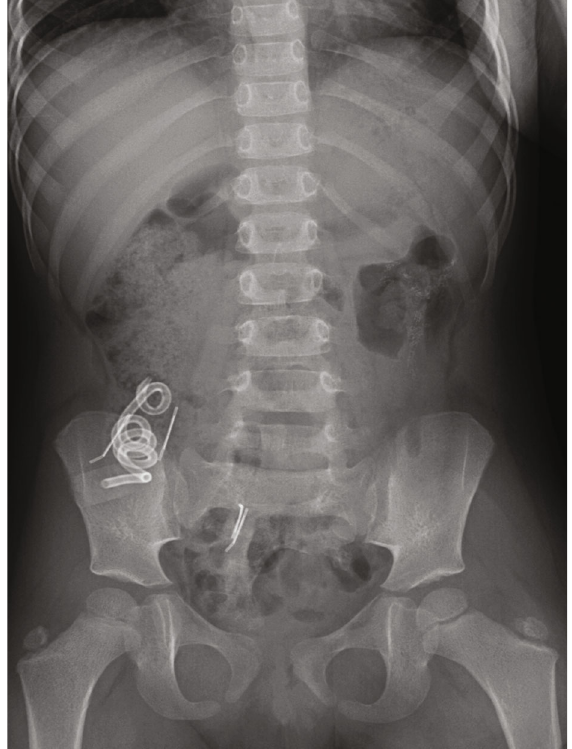
Figure 1: Supine frontal radiograph of the abdomen demonstrates the cecostomy catheter and surgical hardware overlying the right lower quadrant. Stool is seen throughout the colon. A dysmorphic sacrum is seen curving to the right, consistent with a known diagnosis of Currarino triad.